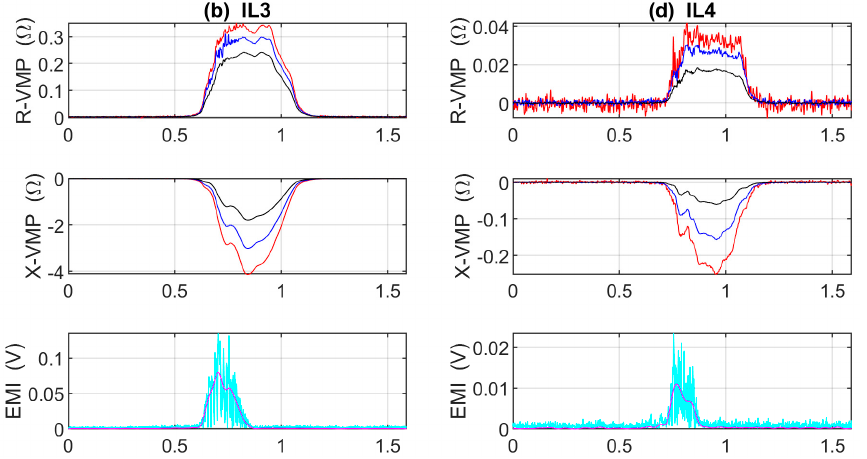
Figure A1. VMPs and EMIs of Hyundai i30 before denoising process. The rest of the description is the same as in Figure 2.